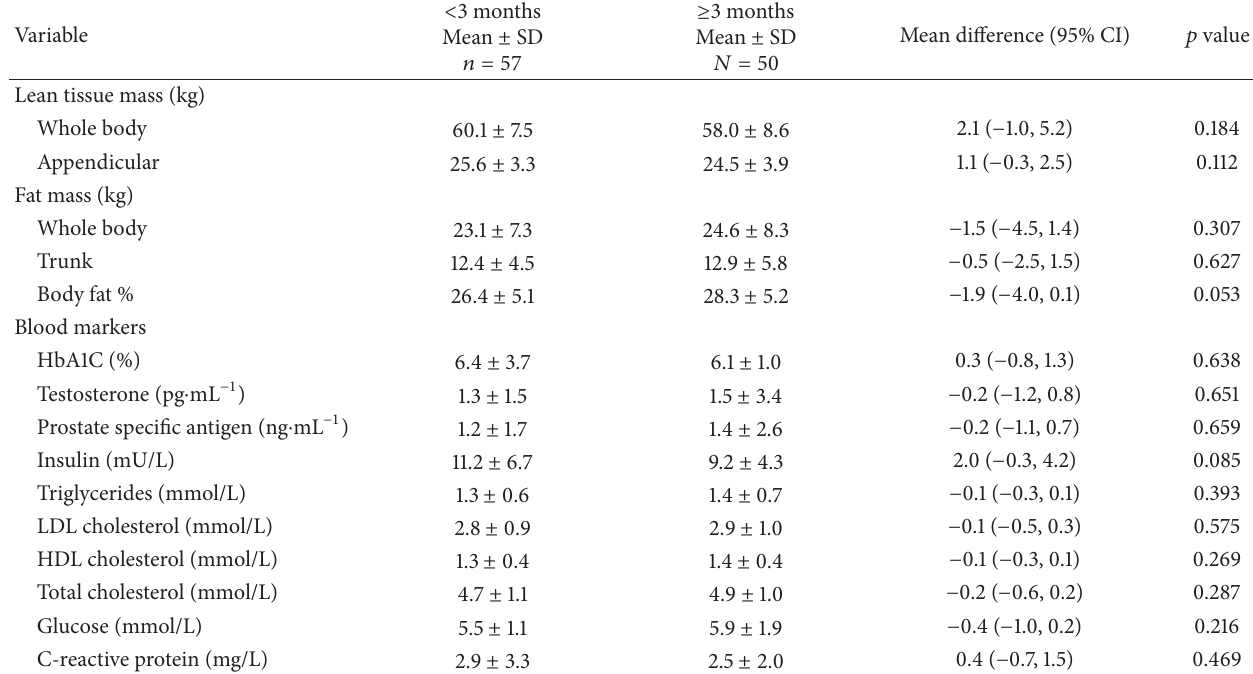
Table 2: Body composition and blood markers for the short- and longer-term androgen deprivation